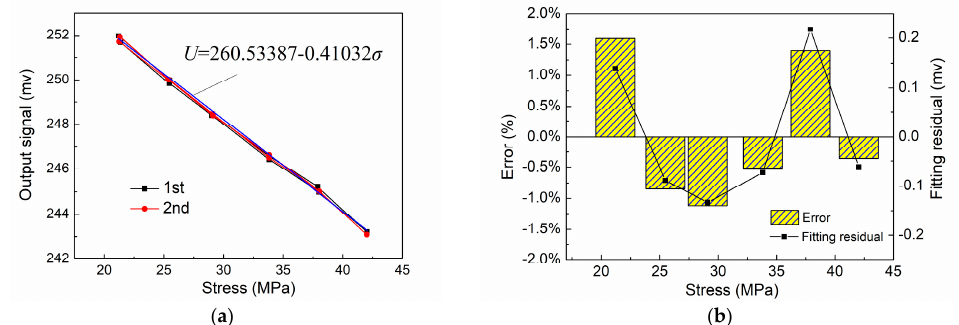
Figure 7. Detection error and repeatability analysis: ( a ) stress detection signal and fitting straight line; ( b ) detection error and fitting residual.